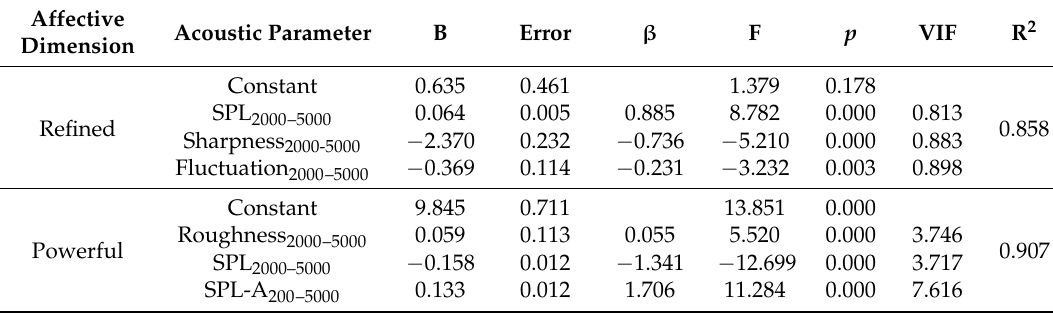
Table 8. Results of regression analysis of affective dimensions for acoustic parameters from 2000 to 5000